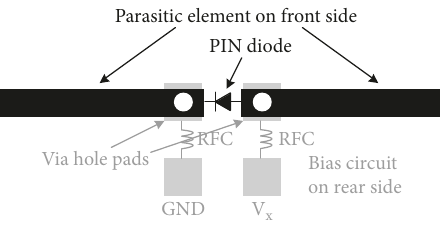
Figure 8: Layout of the parasitic element antenna mounting a recon fi gurable reactive load with bias